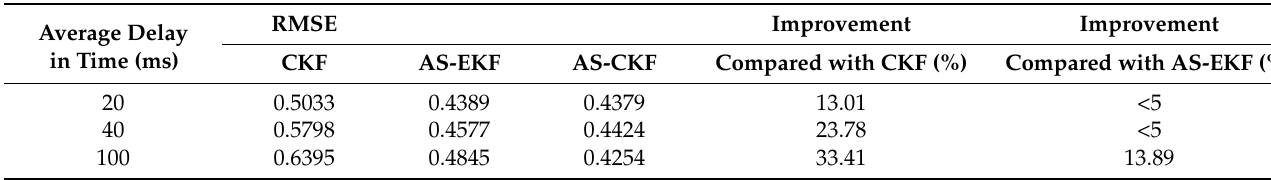
Table 4. RMSE error of